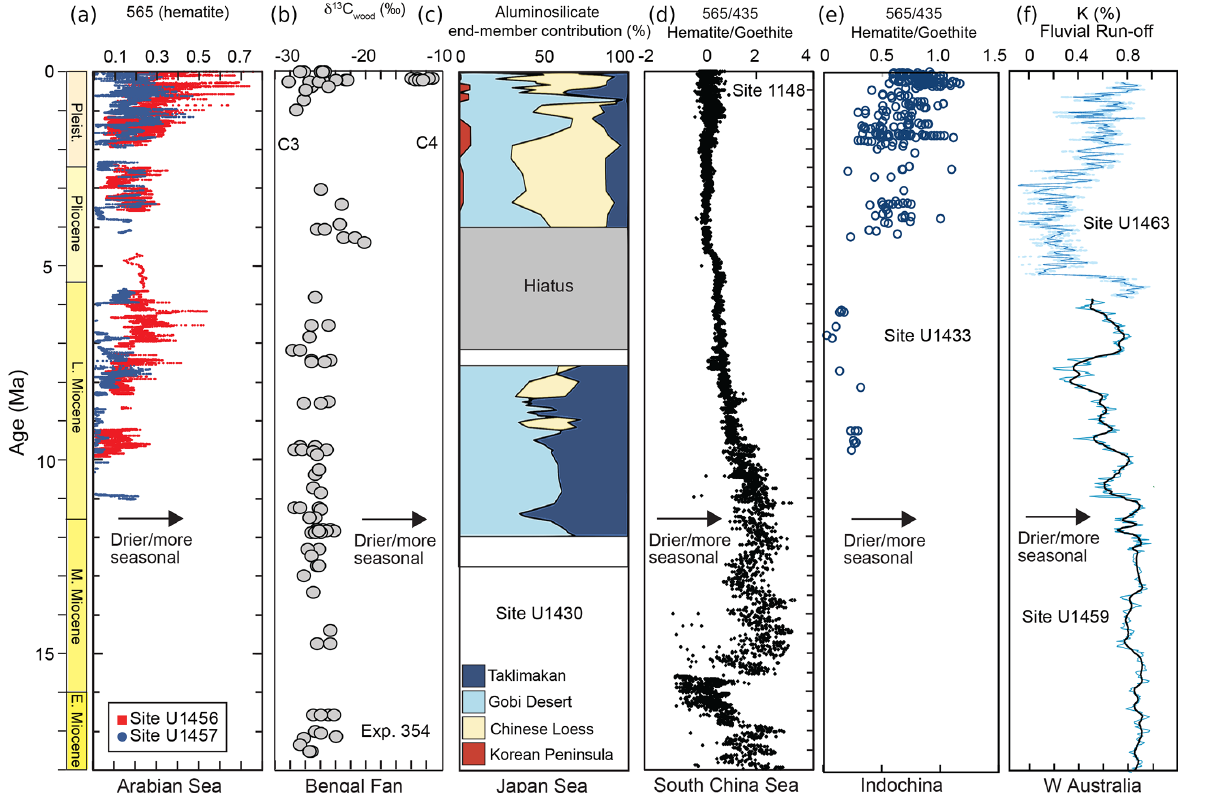
Figure 10. Compilation and comparison of monsoon related proxies from across the Asia–Australia region. (a) Hematite content from Laxmi Basin measured by 565nm spectral analysis (Zhou et al., 2021), (b) δ 13 C of wood from Bengal fan sediments (data from Lee et al., 2019), (c) source of wind-blown sediment in the Sea of Japan (Anderson et al., 2020), (d) hematite / goethite relative abundance tracked by 565/435nm ratio from spectral analysis from northern South China Sea (Clift et al., 2008), (e) hematite / goethite relative abundance tracked by 565/435nm ratio from SW South China Sea (data from Liu et al., 2019) and, (f) K (%) contents from western Australia acting a proxy for fluvial run-off at Site U1463 in NW Australia (data from Christensen et al., 2017) and Site U1459 in SW Australia (data from Groeneveld et al.,